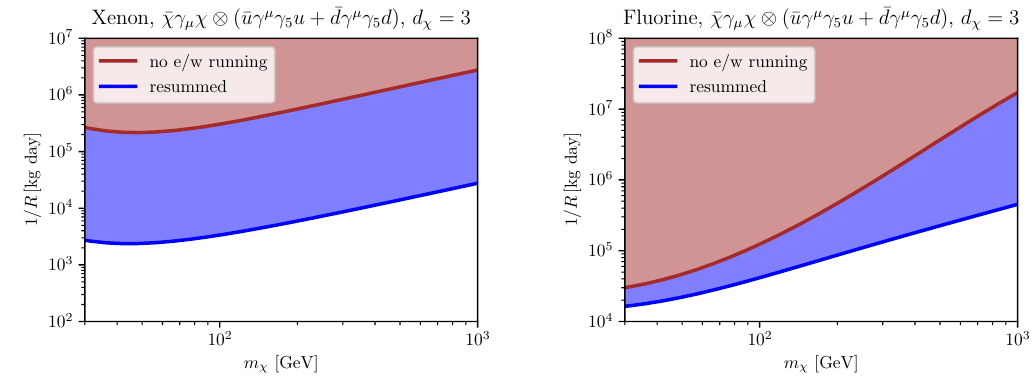
Figure 15 . Same as (cid:12)gure 14, but for I (cid:31) = 1 ; Y (cid:31) = 0 Dirac fermion DM with additional dimension- six interactions coupling a DM vector current to the SM axial-vector (cid:12)rst generation current, setting (cid:3) = 1